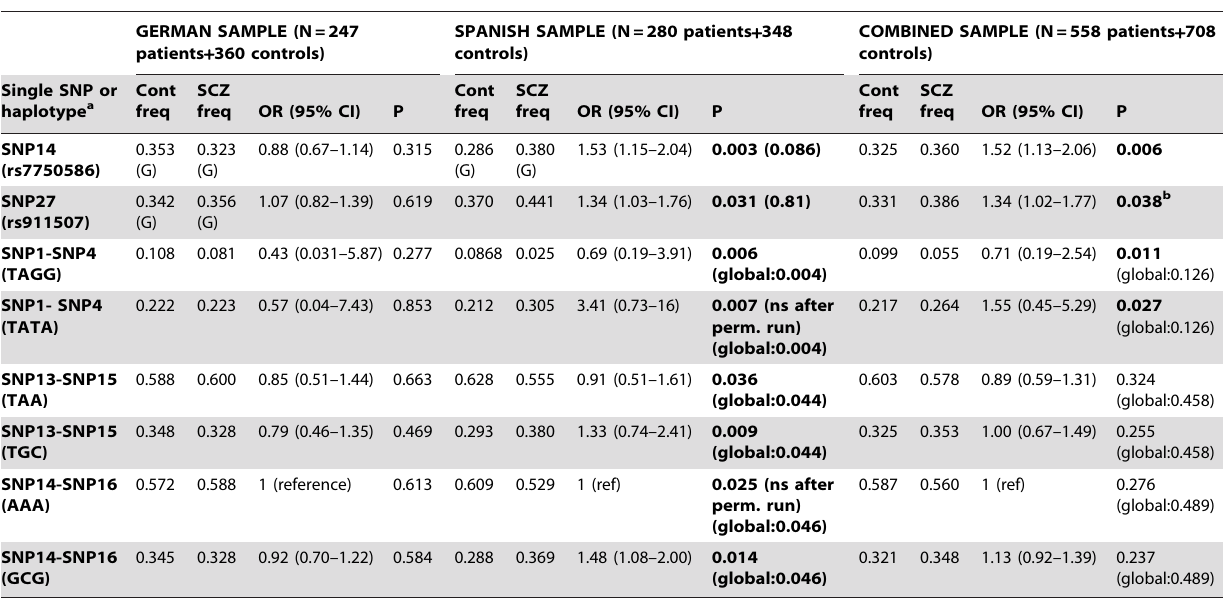
Table 1. Single alleles and haplotypes of the AHI1 region associated with schizophrenia in the present study.